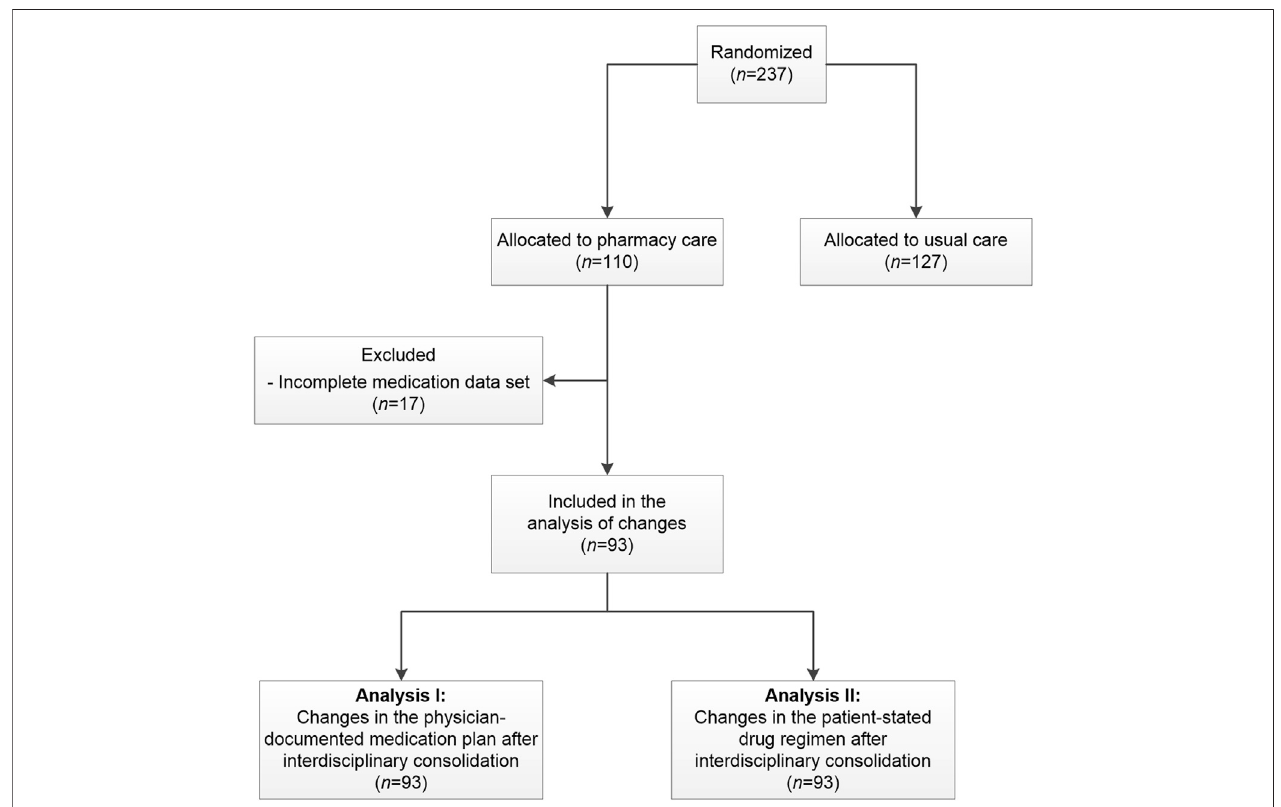
FIGURE 1 | Subanalysis fl